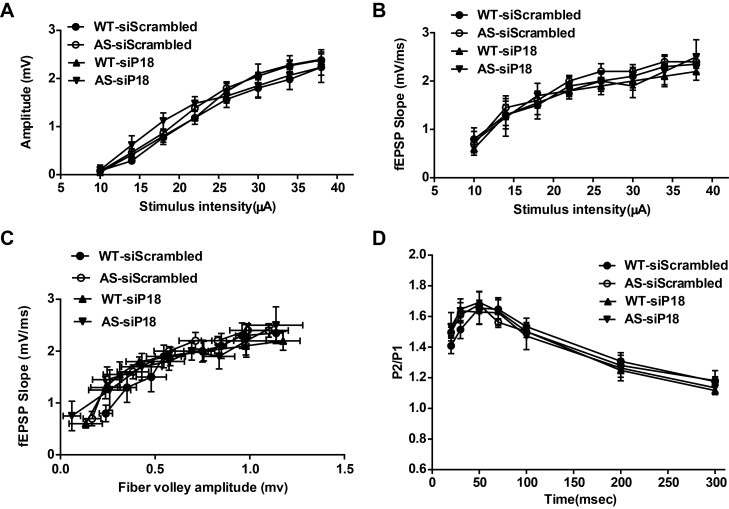
Effects of p18 knockdown in hippocampal CA1 region on input/output curves and paired-pulse facilitation in WT and AS mice.Related to Figure 6. (A–C) Input/output curves. Amplitudes of field EPSPs (A) and the slope of the field EPSP (B) were determined for various intensities of stimulation. (C) Relationship between the slope of the evoked fEPSPs and the corresponding fiber volley amplitude. The results are means ± SEM; n = 3 mice; there were no significant differences among the four groups of mice. (D) Paired-pulse facilitation. The amplitude of the second response of a paired-pulse was calculated as a percentage of the amplitude of the first response for various inter-pulse intervals. The results are means ± SEM; n = 5 mice; there were no significant differences among the four groups of mice.